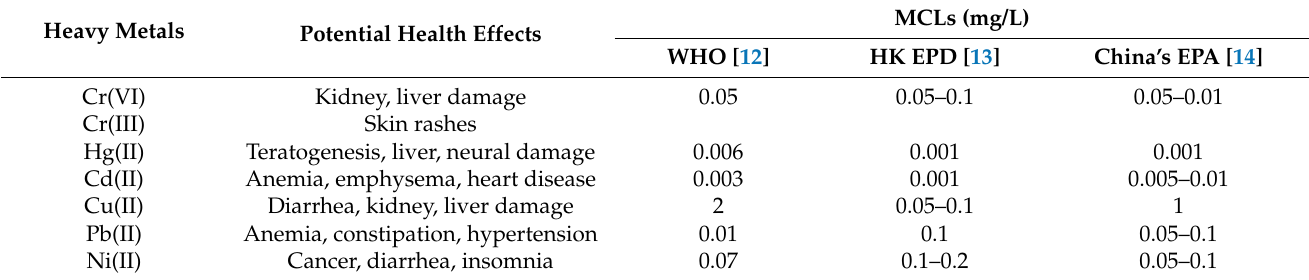
Table 1. Maximum contaminant level (MCL) of heavy metals in aqueous